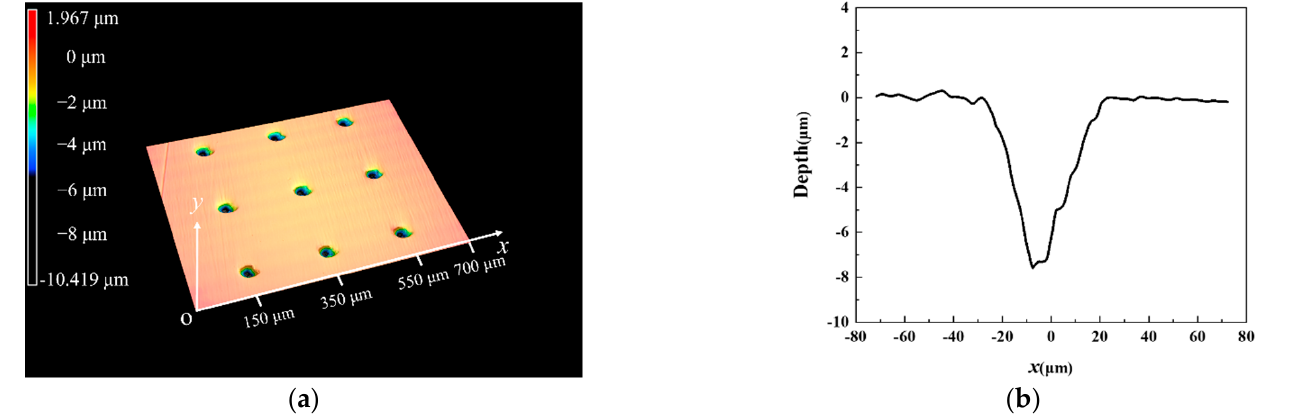
Figure 3. Topography of textured steel ball surface: ( a ) 3D topography and ( b ) 2D profile.